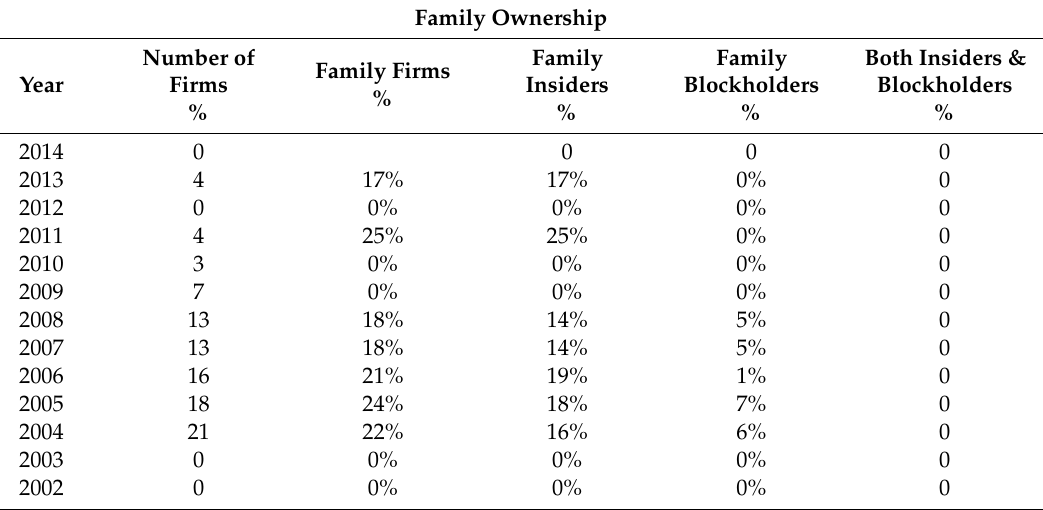
Table 8. Firms older than 10